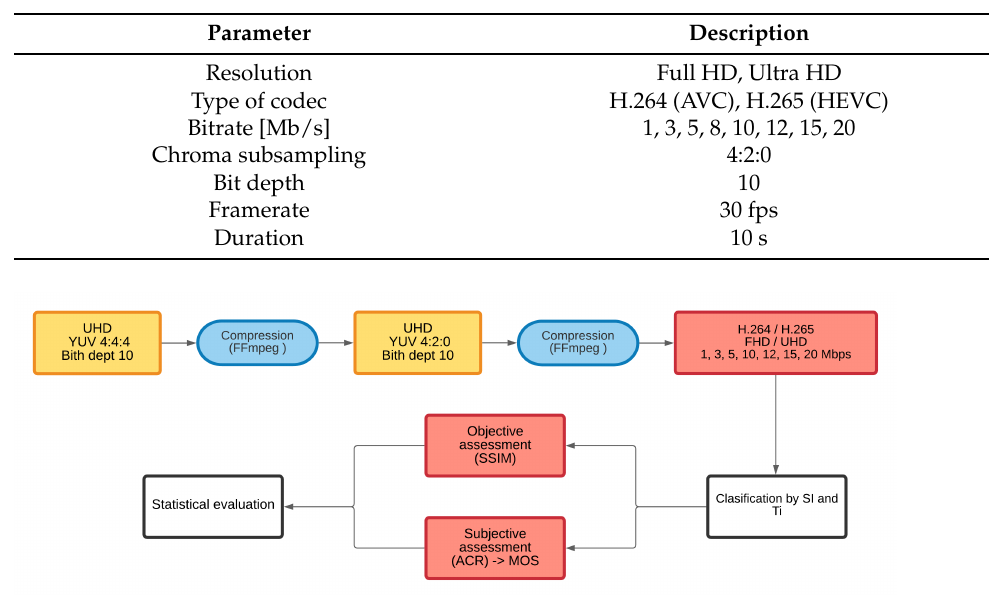
Table 2. Parameters for encoding.